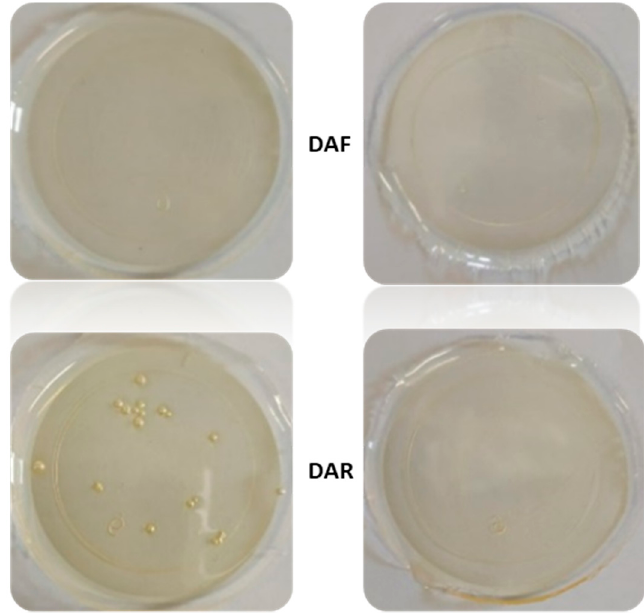
Figure 2. Comparison of adhesive films with 70 mol% − OH groups from polyol without FA (left) and with FA (right) for formulations incorporating DAF (PUR-B02, 18.7% TB and PUR-B03, 13.7% TB) or DAR (PUR-B09, 19.5% TB and PUR-B10, 13.7% TB).